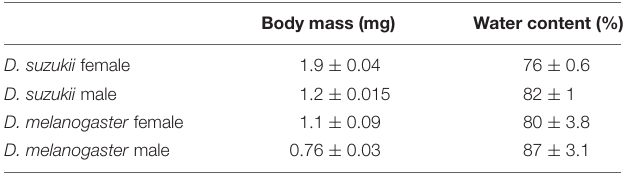
TABLE 2 | Body mass and water content of D. suzukii and D. melanogaster